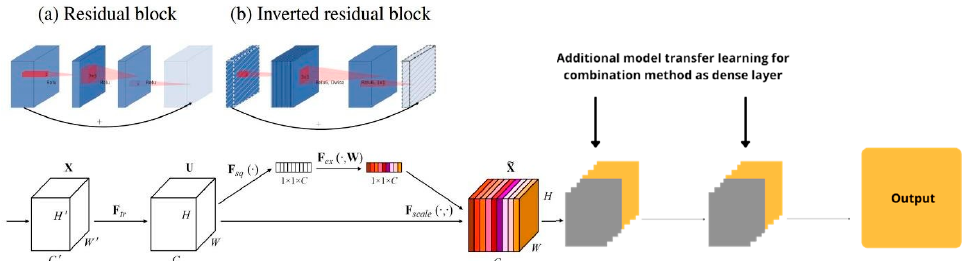
Figure 5. Architecture of the proposed model. ( Top ) Large block placement application in exchange for small blocks in EfficientNet; ( Bottom-Left ) squeeze-excitation is applied to the learning process by adjusting the model used for the input scale data. [6], and ( Bottom-Right ) the dense layer is an additional learning model combined with the main model to produce the learning output.